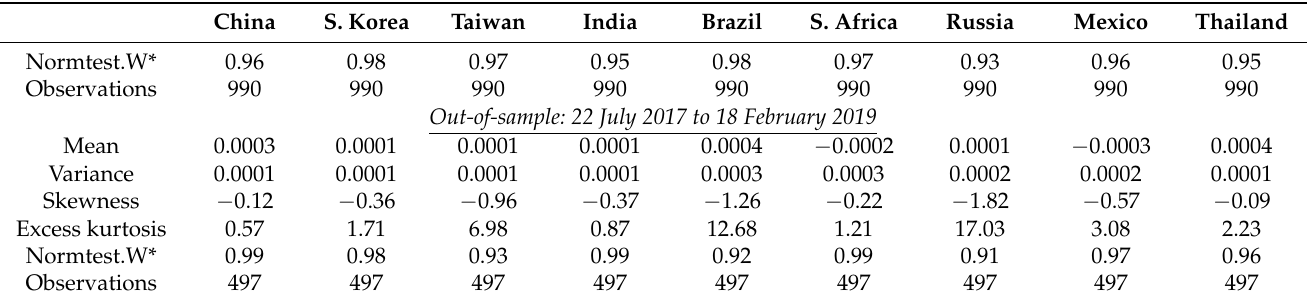
Table 2. Summary statistic of EM index.